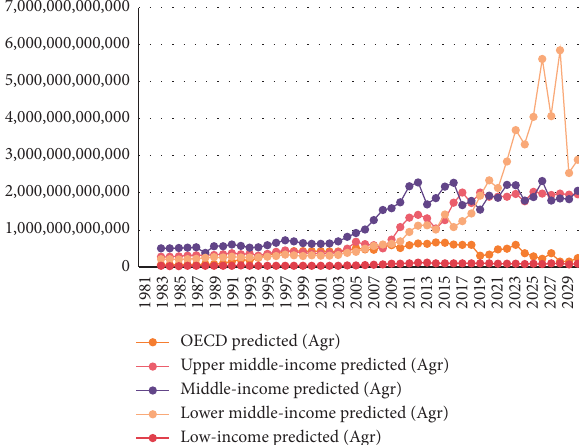
Figure 5: Forecasted agriculture output by the ANN method. Source: sketched by the authors.